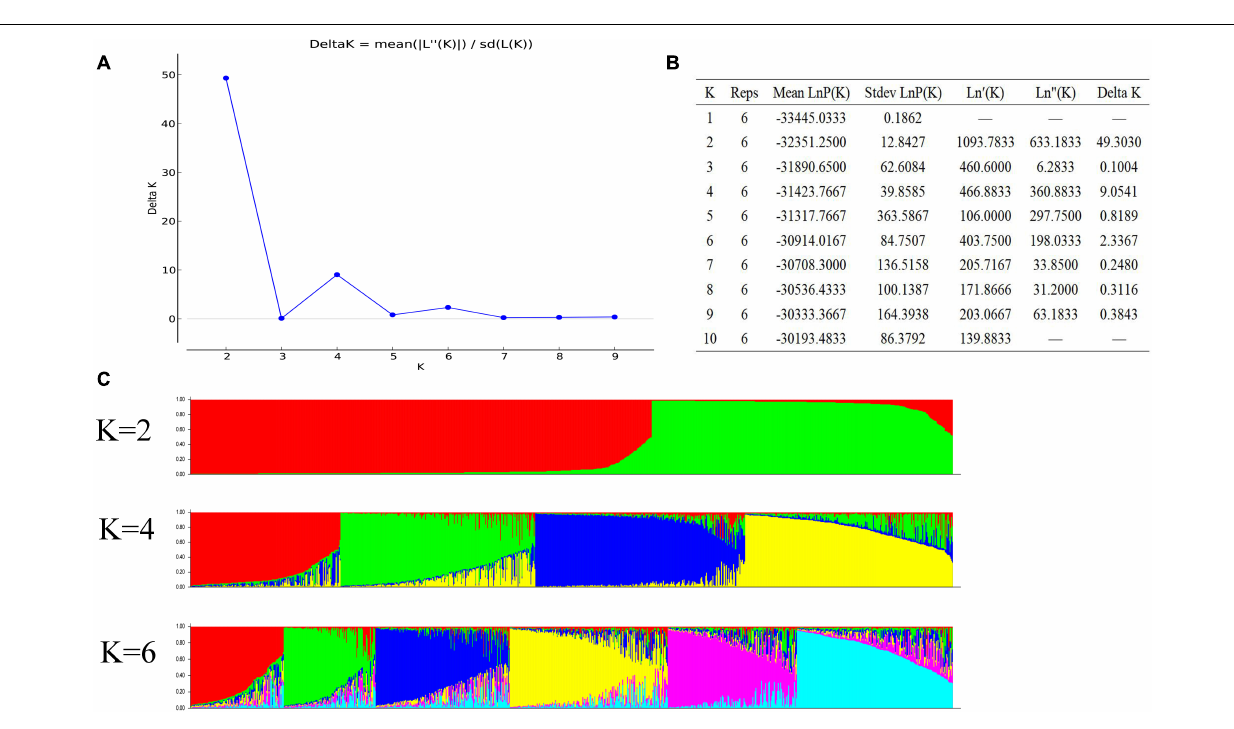
Frontiers in Genetics |